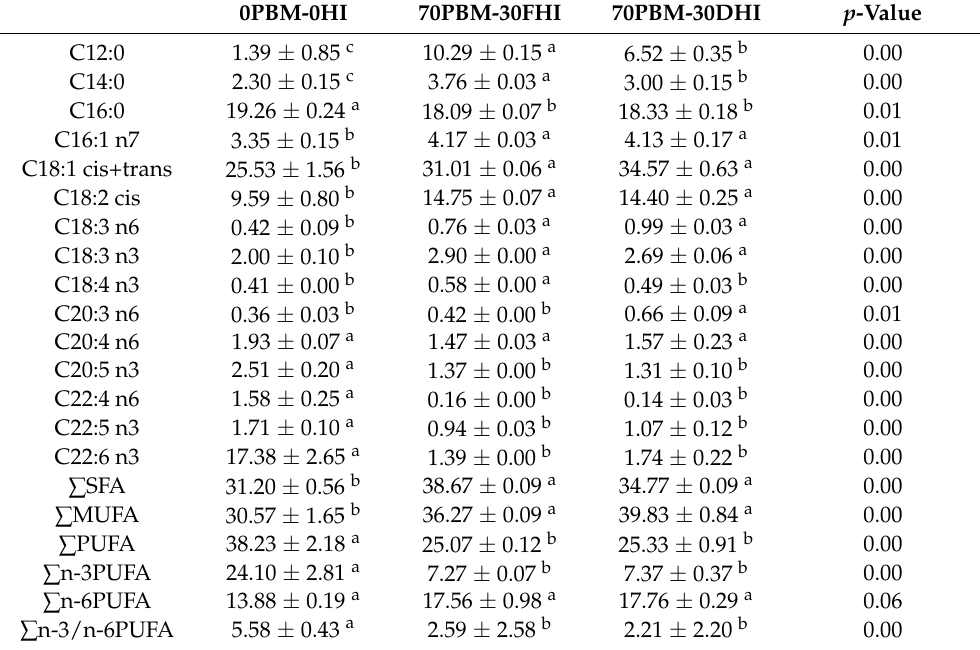
Table 3. The fatty acid composition of barramundi fillets (skinless) from fish fed with a mixture of poultry by-product meal (PBM), full-fat Hermetia illucens (FHI), and partially defatted Hermetia illucens (DHI) larvae meal for 56 days for the complete replacement of FM, obtained from our earlier study [15]. The results are expressed as means ± the standard error ( n = 3) and different superscript letters within the row represent significant variation between the treatments. ∑ indicates the summation of individual fatty acids.